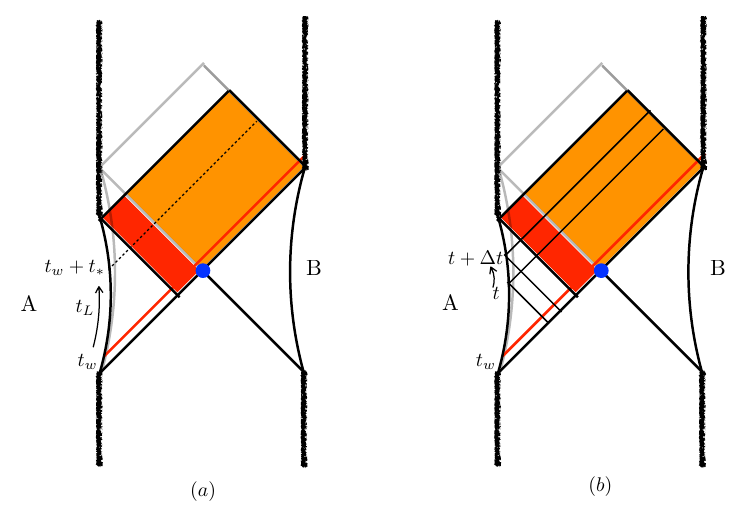
Figure 14 . Penrose diagrams for perturbed charged black